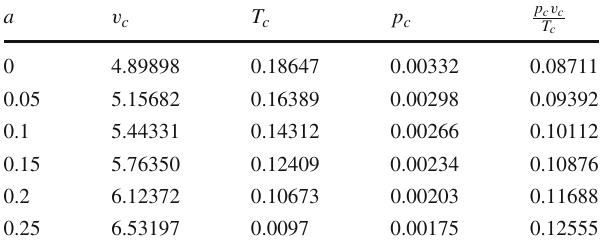
Table 1 Behaviour of the critical parameters v c , T c , p c and p c v c different values of a and for Q = 1, α = 0 . 01 and ω q = − 2 / 3